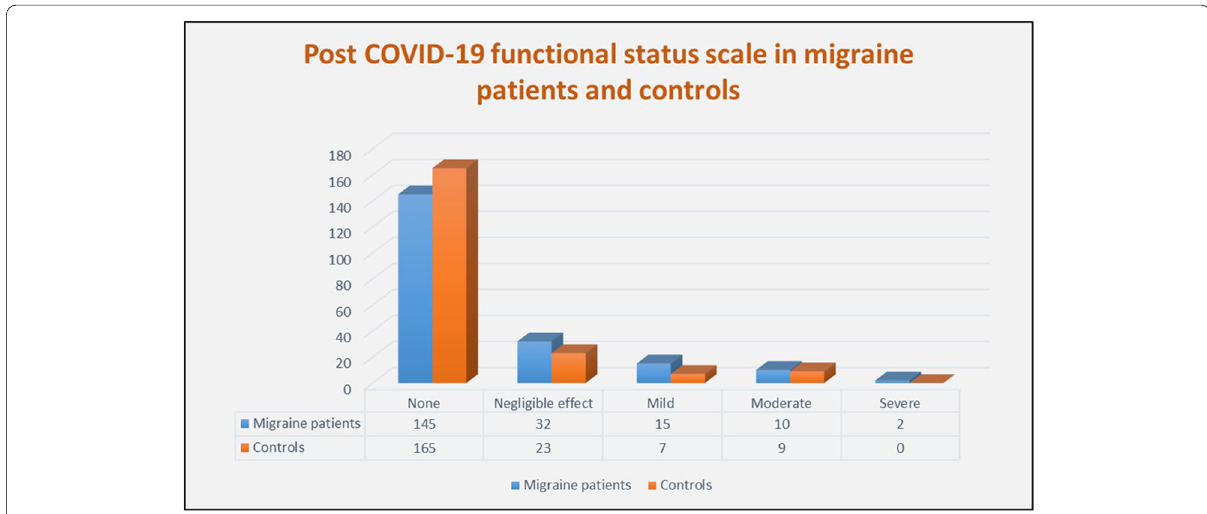
Fig. 3 Post‑COVID‑19 functional status scale in migraine patients and controls